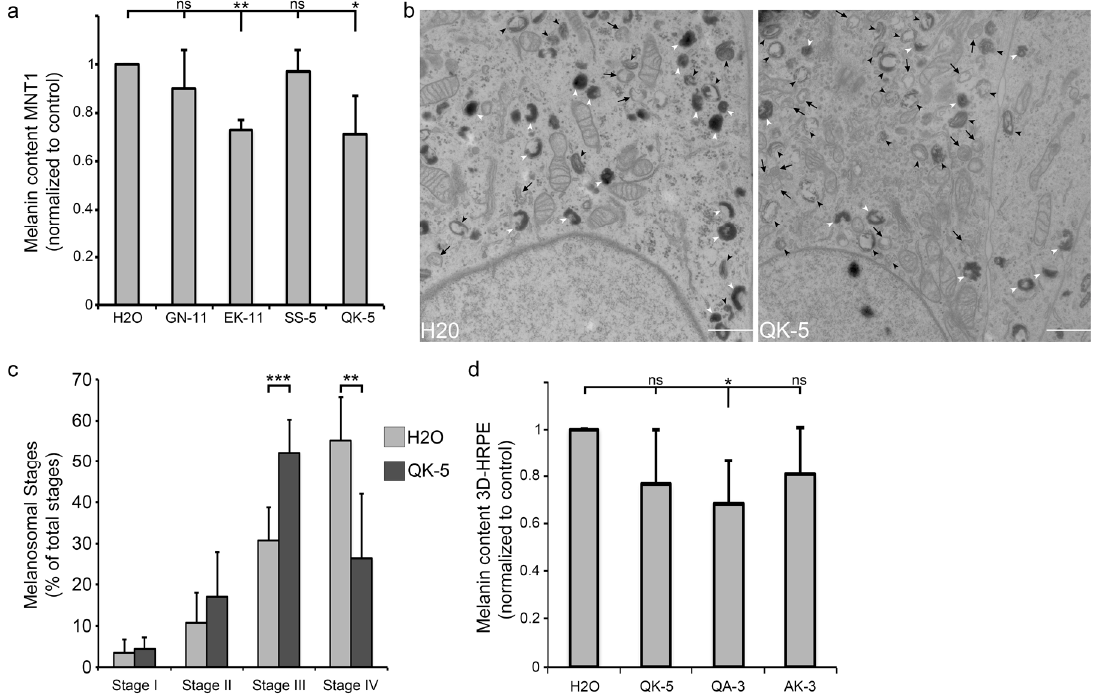
Figure 2. AP-1-derived peptides impact melanin production and melanosome biogenesis. ( a ) Melanin